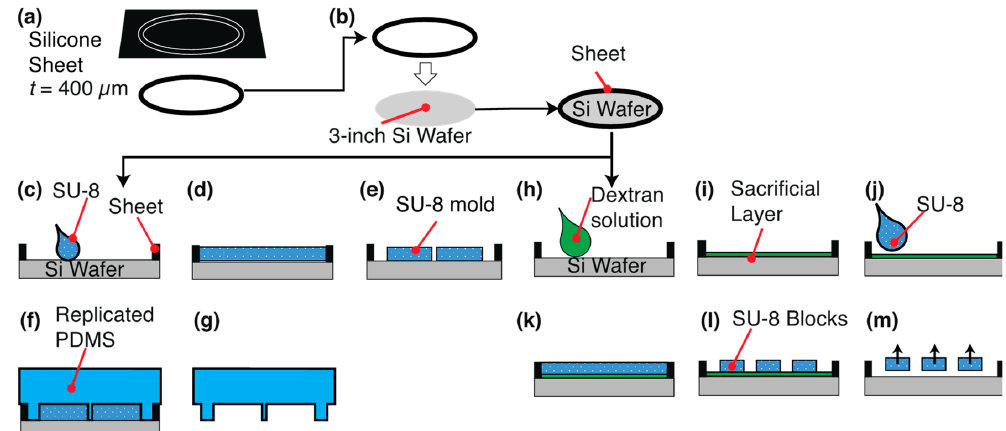
Figure 2. Schematic of a SU-8 mold fabrication process. ( a ) Ring formation from a silicone sheet. ( b ) Placement of a rubber sheet on a wafer. ( c – g ) Fabrication of a polydimethylsiloxane (PDMS) microchamber from a SU-8 mold. ( c ) SU-8 dispensing, ( d ) flattening by gravity. ( e ) SU-8 photolithography. ( f ) PDMS molding. ( g ) Release of the PDMS micro chamber. ( h – m ) Fabrication of the SU-8 blocks. ( h ) Dispensing of a dextran solution. ( i ) Spin-coating of the dextran. ( j ) SU-8 dispensing. ( k ) Flattening by gravity. ( l ) SU-8 photolithography. ( m ) Release of the SU-8 blocks in water.